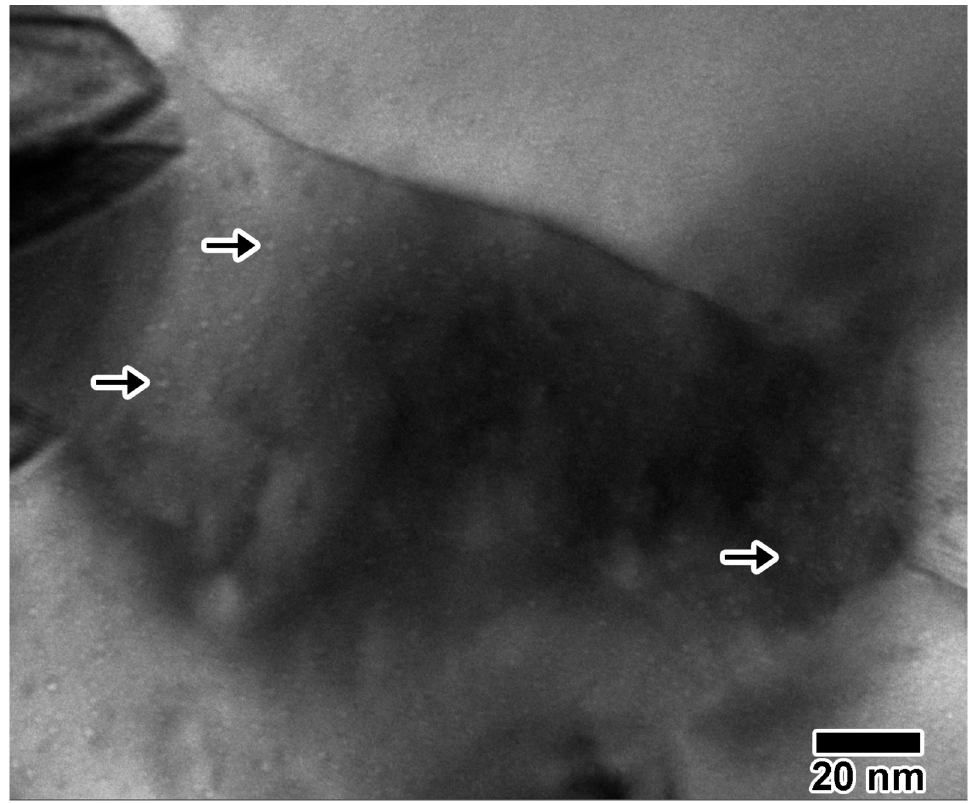
Figure 7. Still image taken after single ion 10 keV He implantation into Au, showing a 1.5-nm bubble distribution in underfocus. This is a zoomed image of the grain indicated by an arrow in Figure 6c. A few bubbles are indicated by arrows.